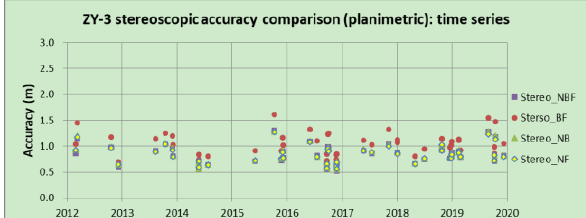
Figure 20. ZY-3 stereoscopic accuracy comparison (planimetric) Num=47